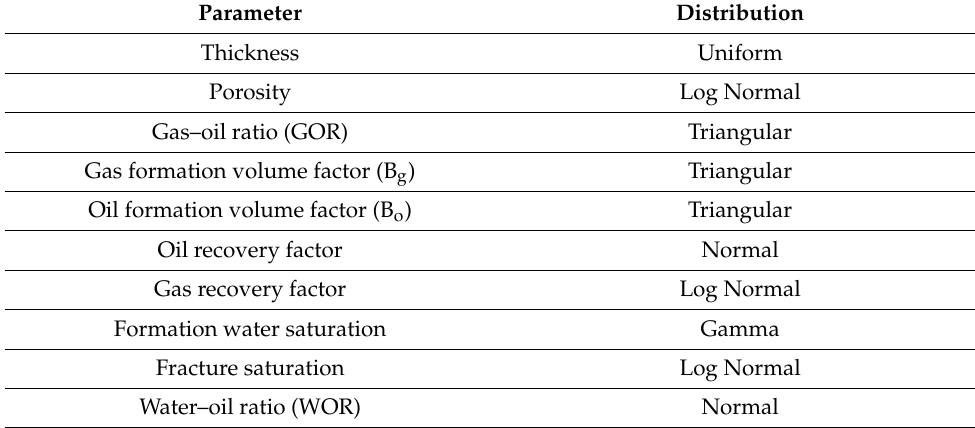
Figure 5. Fitted uniform distribution of Jafurah Formation thickness (Tiers 1 to 3). Table 3. Summary of probabilistic base case distribution of inputs.